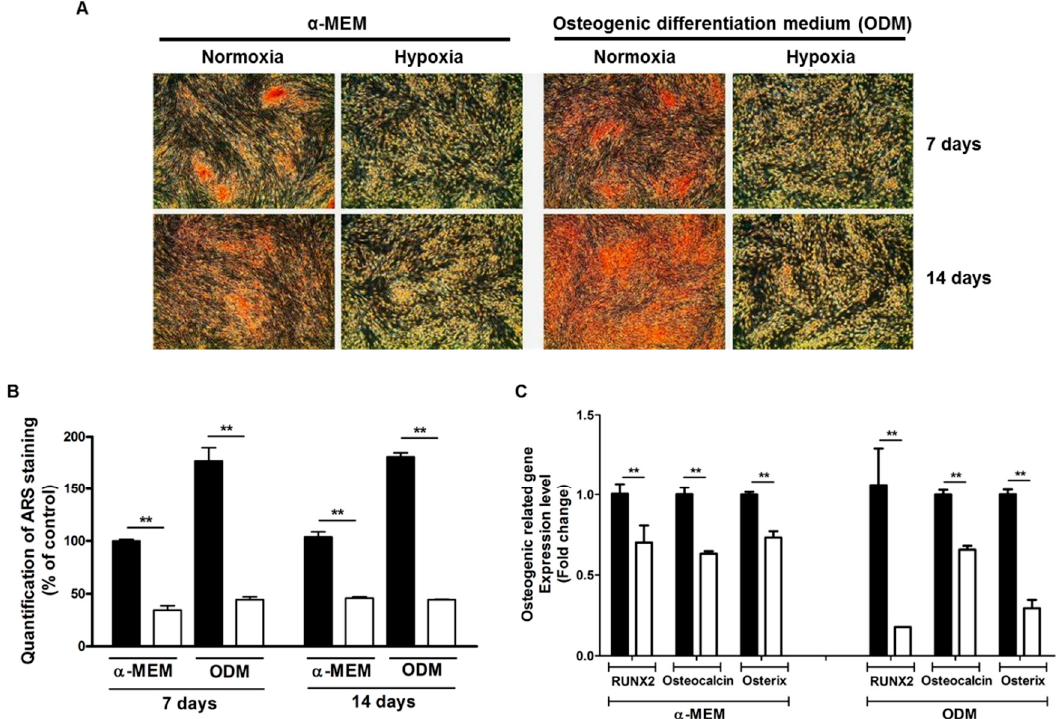
Figure 1. Hypoxia suppresses the spontaneous mineralization and osteogenic differentiation of ASCs. ASCs were cultured in α -MEM and osteogenic differentiation medium (ODM) for 7 and 14 days, and then stained with Alizarin Red S (ARS). ( A , B ) Hypoxia (2% O 2 ) significantly reduced the ARSstaining of ASCs (red) in α -MEM and ODM (40 × ), and ARS staining was measured; ( C ) osteogenic differentiation markers such as RUNX2, osteocalcin, and osterix were significantly reduced under hypoxia. Normoxia: black bars, Hypoxia: white bars. ** p < 0.01.